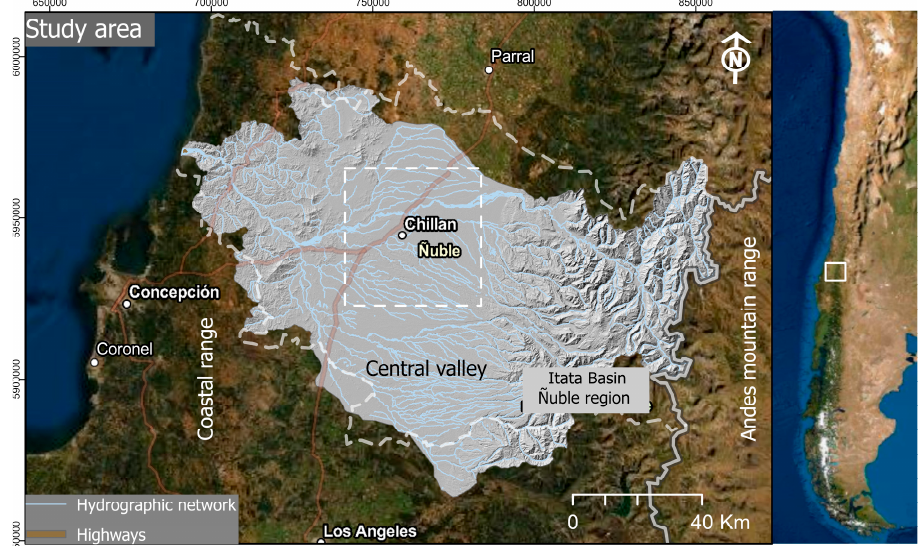
Figure 1. Study area: Chile central valley, Chillan location in Itata basin, background Digital Elevation Model (DEM) ALOS Palsar 30 mt.